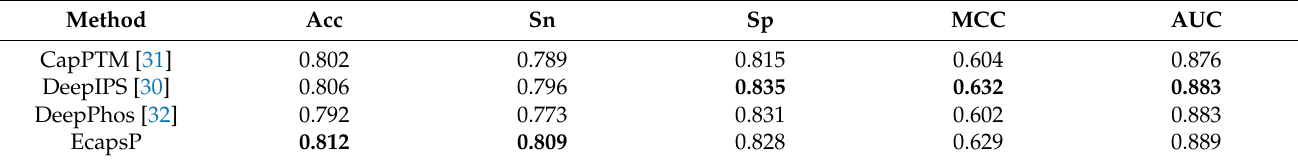
Table 6. Prediction performance of various deep learning models on a test dataset of eukaryotic phosphorylation